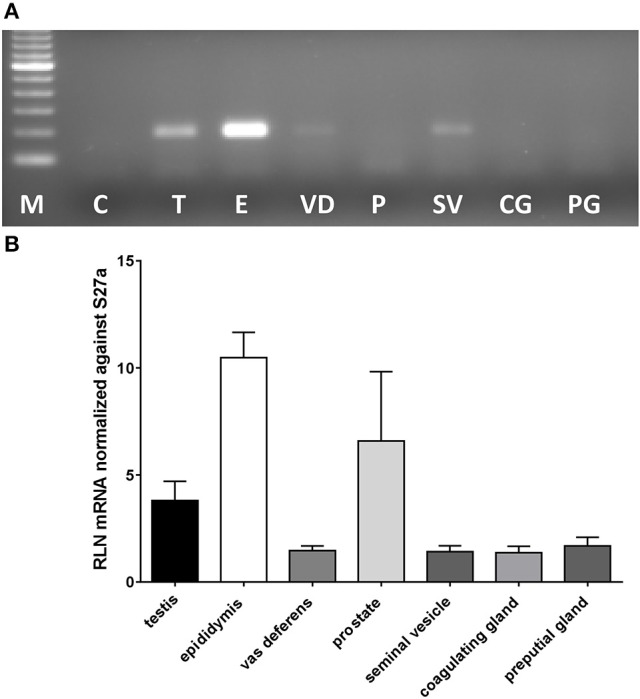
Real-time qRT-PCR quantification of Rln transcript levels in RNA extracted from testis (T), epididymis (E), vas deferens (VD), prostate (P), seminal vesicles (SV), coagulating glands (CG), and preputial glands (PG) from male wild type mice. Note that whereas most tissues derived from the DUK strain, prostate additionally derived from CD1 and CD57/Black 6 strains. (A) Example of PCR products from individual tissues following limited PCR cycles (this included prostate from DUK mice). (B) Relative transcript level normalized against Rps27a (mean ± SEM; n = 3–4 individuals per tissue).